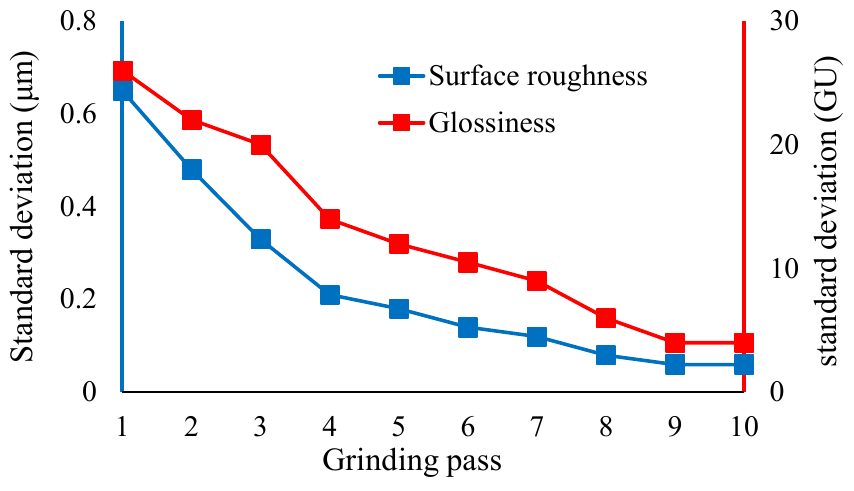
Figure 14. The standard deviations of surface roughness and glossiness of measuring points. The dimensional errors of rough grinding passes are shown in Figure 15. It can be seen that the dimensional errors are still within the tolerance range after the adjustment of the actual grinding depth, which proves the effectiveness of the compensation method. It is also proved that the consistency control method of surface quality will not make the dimensional error exceed the tolerance range.